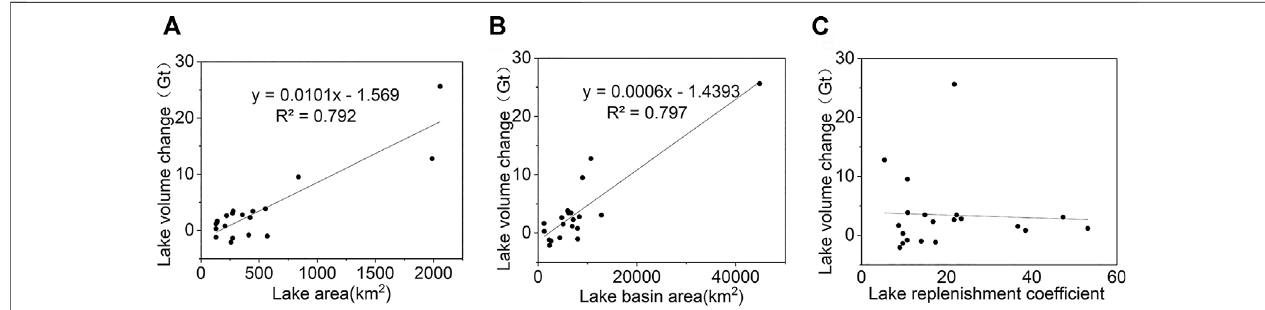
FIGURE 5 | Relationship between lake area, basin area, replenishment coef fi cient and lake volume change. (A) Lake area and lake volume change; (B) lake basin area and lake volume change; and (C) lake replenishment coef fi cient and lake volume change.